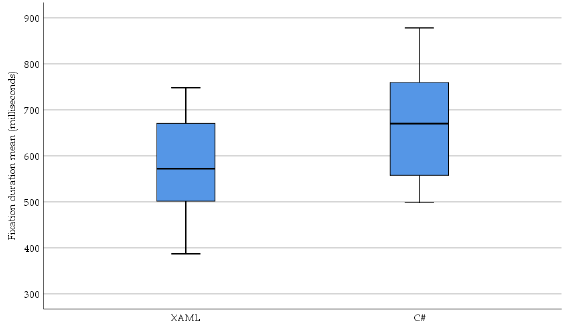
Figure 8. The distribution of the fi xation duration mean (milliseconds) is based on XAML and classic C#.